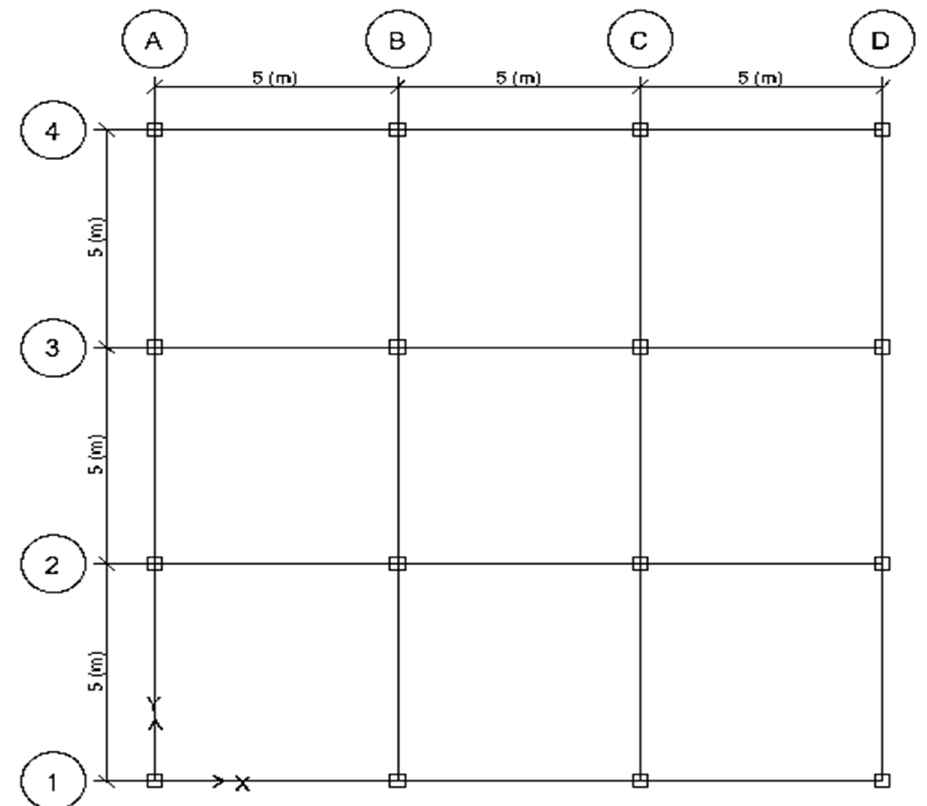
Figure 1. Modeled buildings’ plan in the Etabs software.